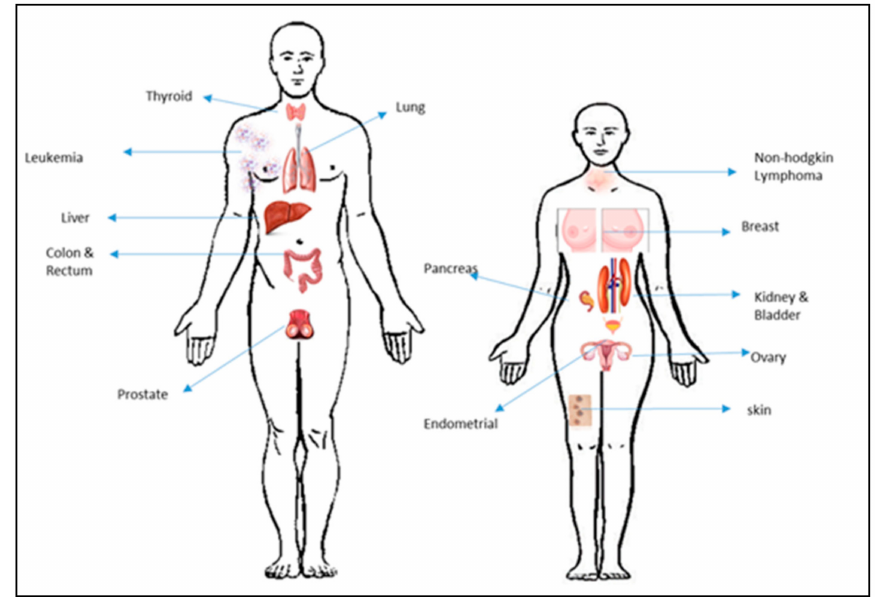
Figure 9. Most common type of cancer in 2018 reported by the American Cancer